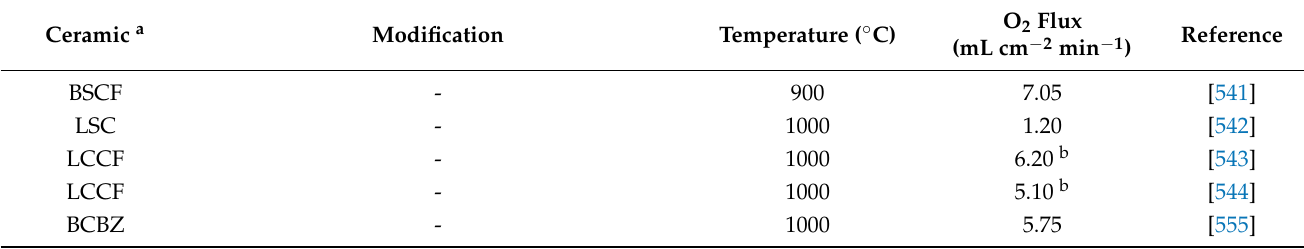
Table 5. Recent reported perovskite hollow fiber membranes for O 2